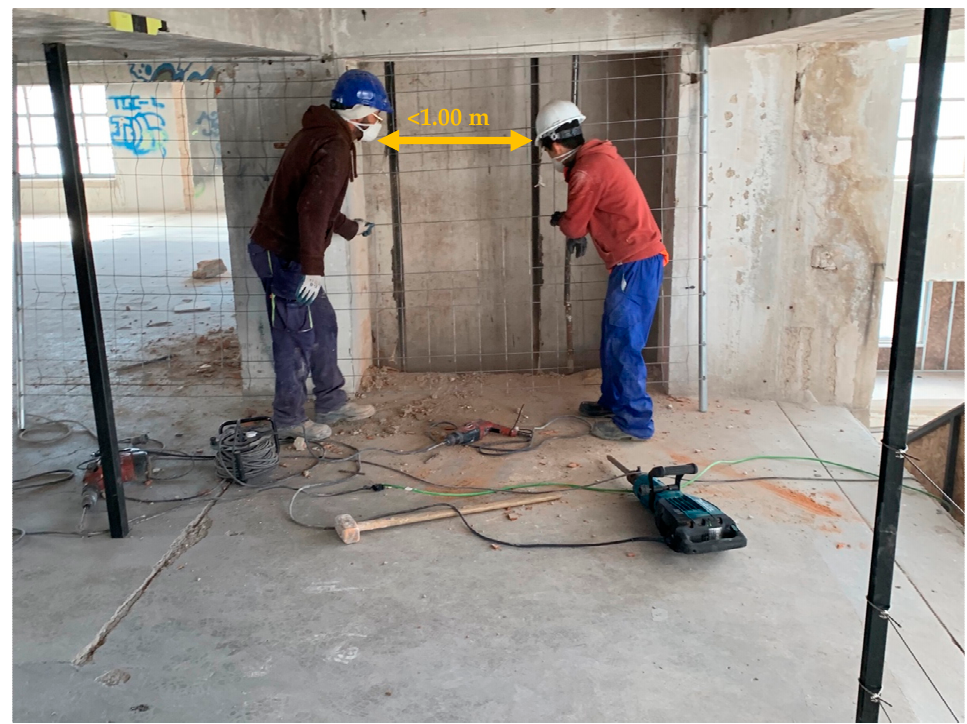
Figure 3. Workers exchanging a protection element in an elevator shaft in a building’s interior rehabilitation work. The photograph indicates the separation distance between workers (author’s photograph).